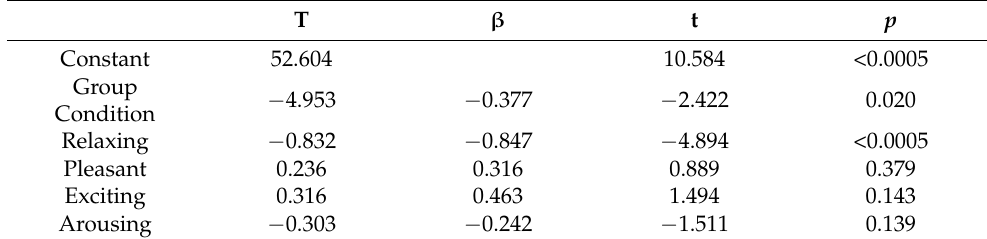
Table 3. Regression model identifying the effect of group intervention and QAL positive subscales on VRS total